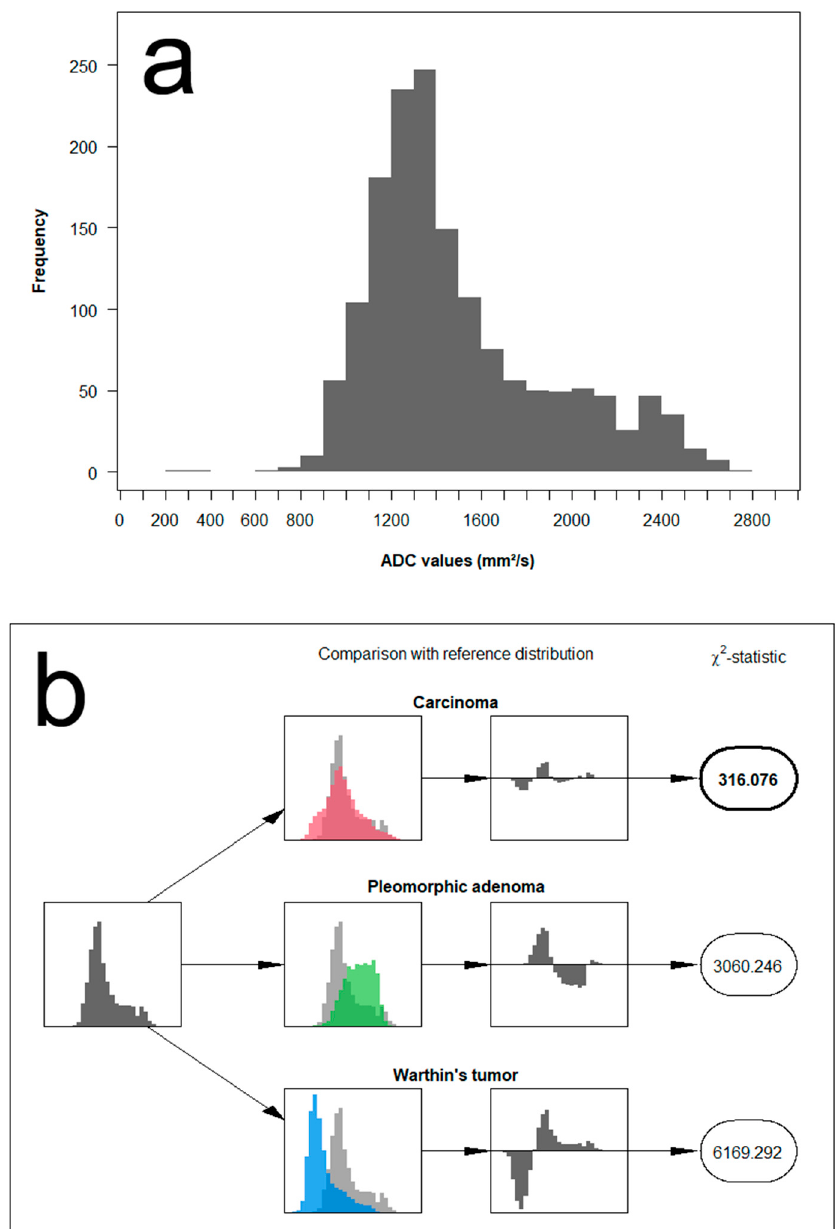
Figure 6. Example of histogram distribution derived from the patient of Figure 3. The image on the upper row ( a ) illustrates the full distribution of ADC values of a malignant parotid lesion. The image on the lower row ( b ) shows the analysis algorithm including a comparison of the measured ADC values to each of the three reference distributions using a Chi² test-statistic. In this example case, the test-statistic indicates a match with reference distribution of malignant parotid tumors.